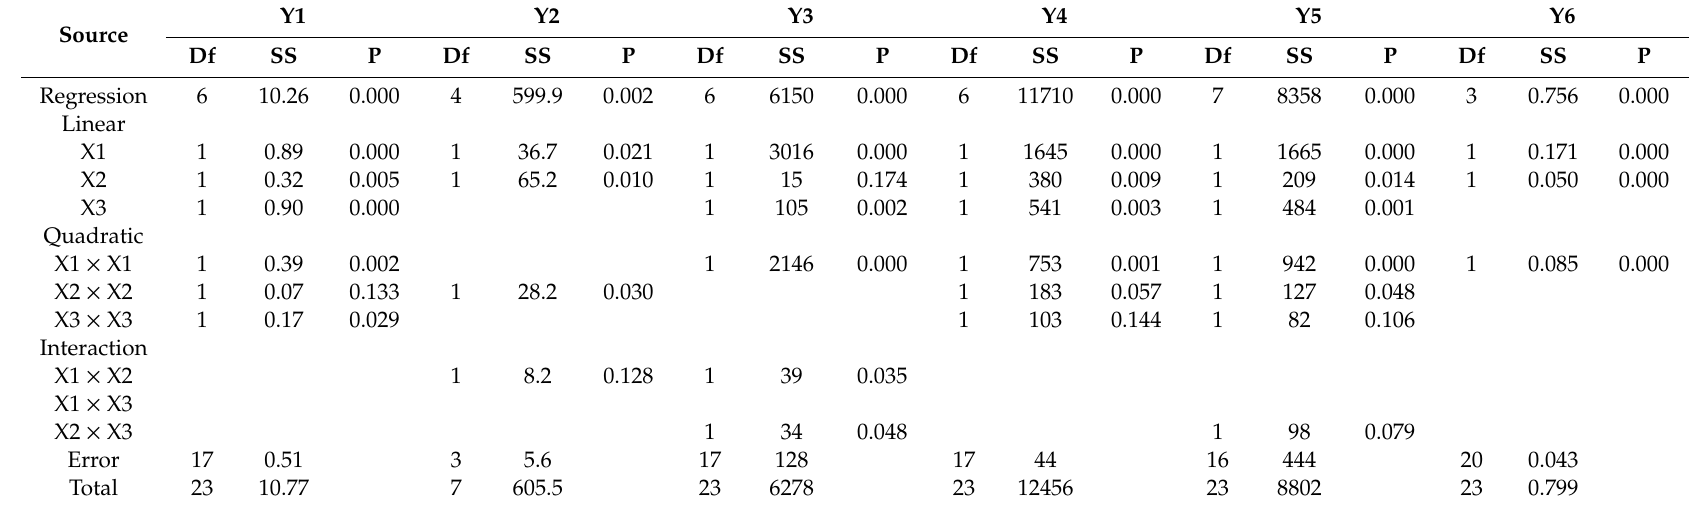
Table 2. ANOVA for response surface regression of sun protection factor (Y1), antioxidant activity (Y2), critical wavelength (Y3), UVA transmittance (Y4), UVB transmittance (Y5), and UVA / UVB ratio (Y6) c of the concentration of sunscreens filters (X1), concentration of extract (X2), and time of irradiation (X3).